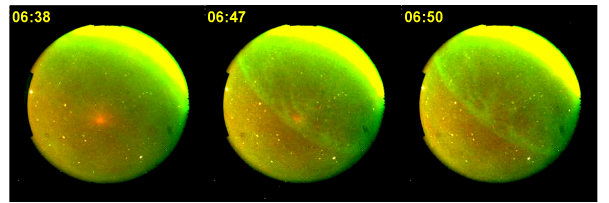
Fig. 11. Widespread highly structured subauroral precipitation (vis- ible as green in these composite color images) drifting slowly across the field of view during a heating experiment on 26 March 2006. The artificial optical emissions (red) appear only in the gaps in the natural